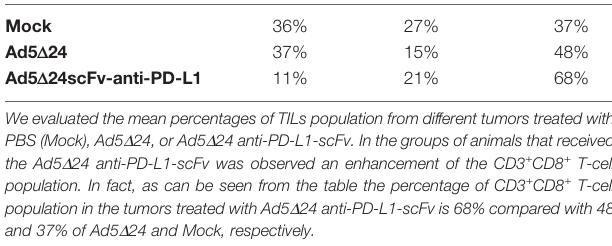
TABLE 1 | Cyto fl uorimetric evaluation of TILs.